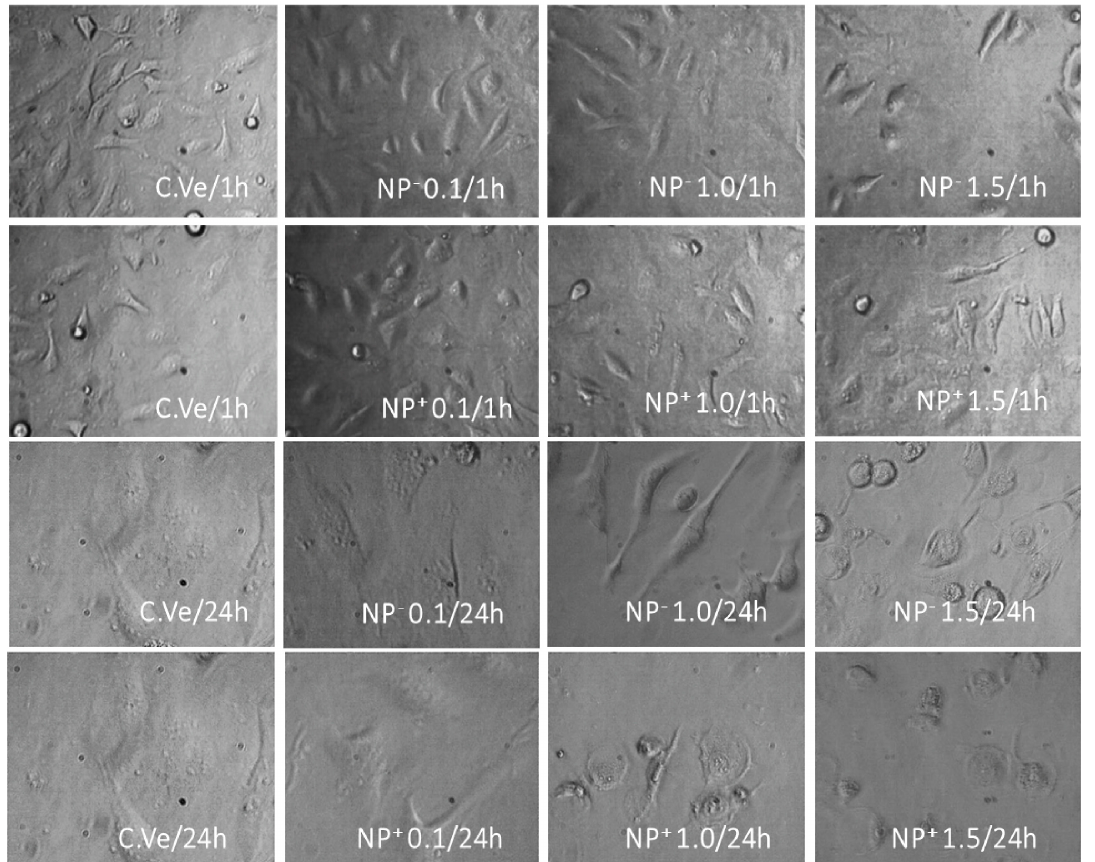
Figure 9. Cell morphology results for various EE/alginate pNPs. HeLa cells were treated with different concentrations (in μ mol) of EE/alginate pNPs at either positive or negative zeta potential. C.Ve = Vehicle control. All images taken at 40× magnification.